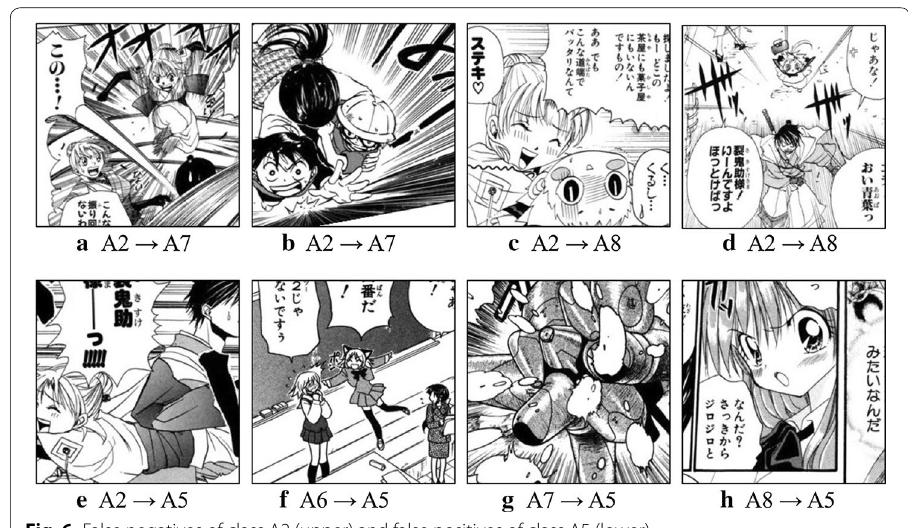
Fig. 6 False negatives of class A2 (upper) and false positives of class A5